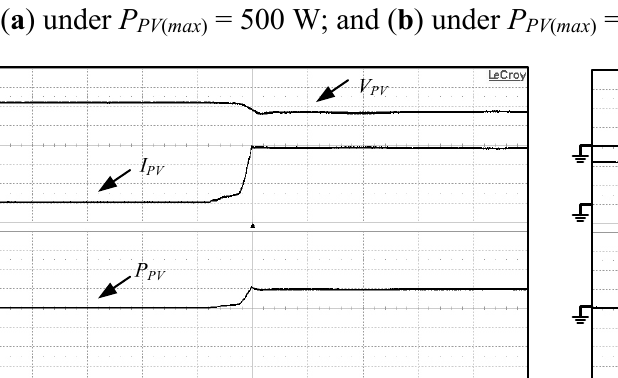
waveforms of PV arrays PV